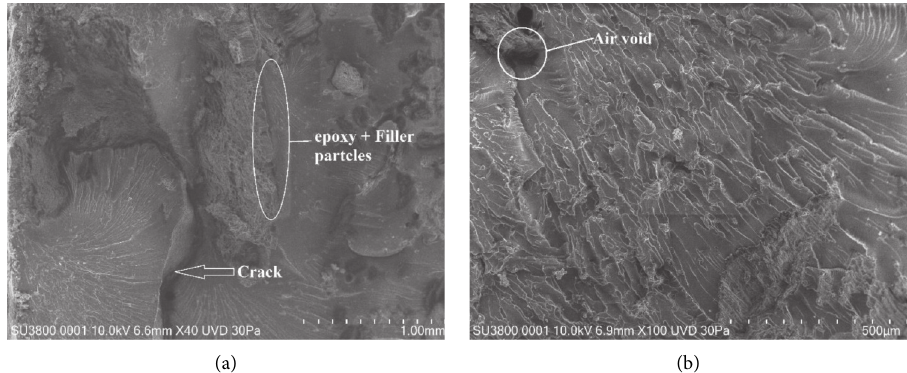
Figure 4: SEM image of broken surface of epoxy composite sample/litchi peel (20 wt%).